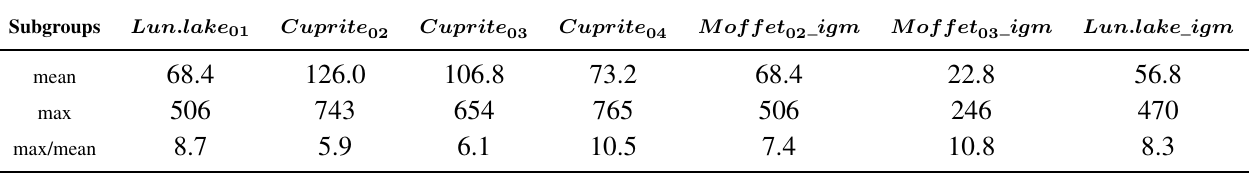
Table 2. Average and maximum quantities of pairwise distances for all of the available bands.